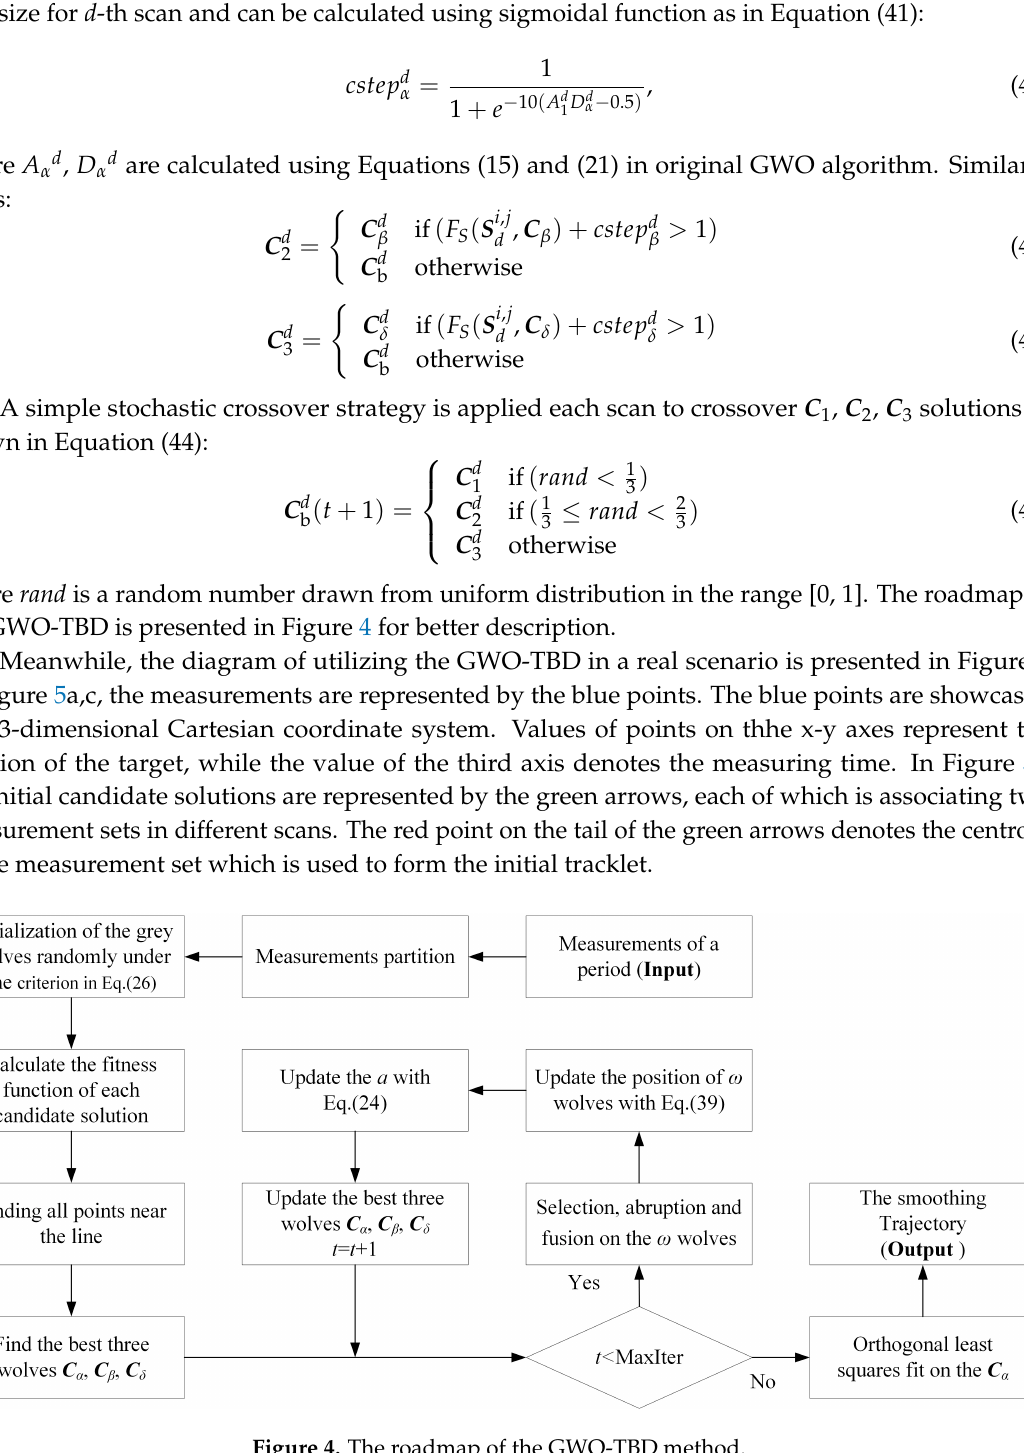
Figure 4. The roadmap of the GWO-TBD method.